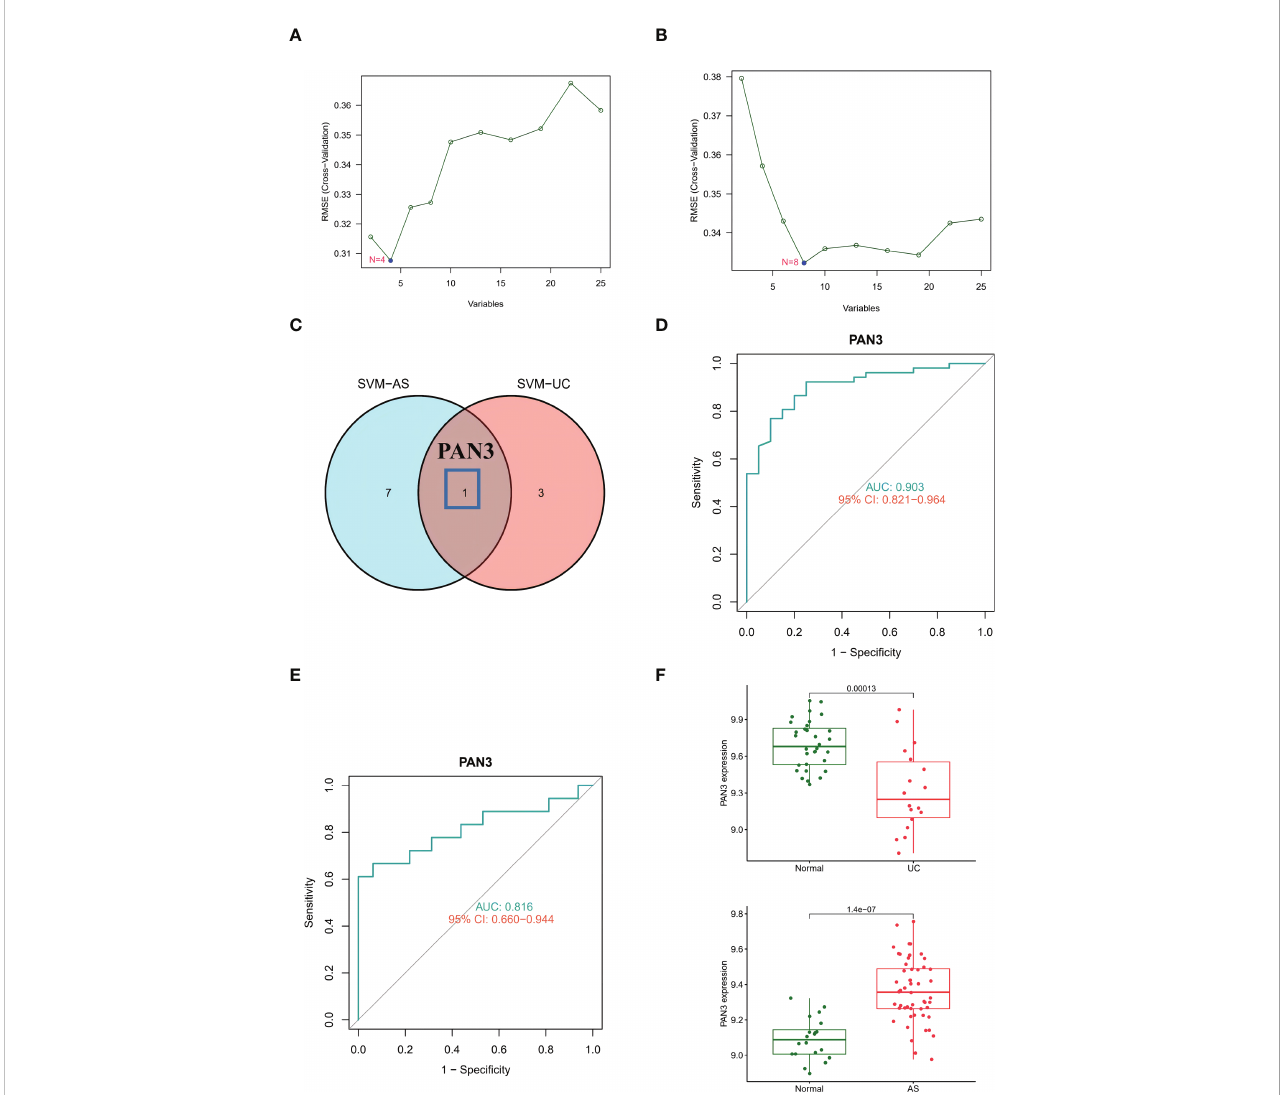
FIGURE 4 (A) SVM-RFE to screen diagnostic markers in GSE126124. (B) SVM-RFE to screen diagnostic markers in GSE73754. (C) The Venn diagram shows the diagnostic biomarkers between UC and AS. (D) ROC curve evaluating the PAN3 diagnostic ef fi cacy in GSE126124. (E) ROC curve evaluating the